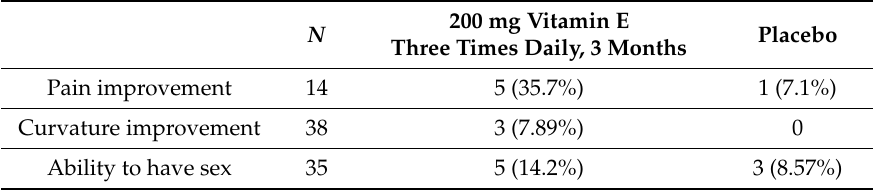
Table 7. Vitamin E vs. Placebo: Randomized, Double-Blind Crossover Study [38].